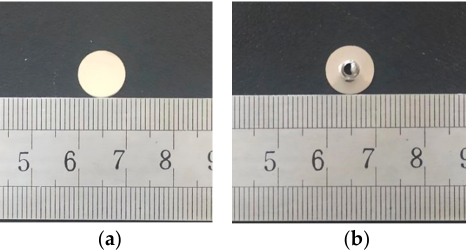
Figure 3. Dimensions of the tensile specimen (mm).